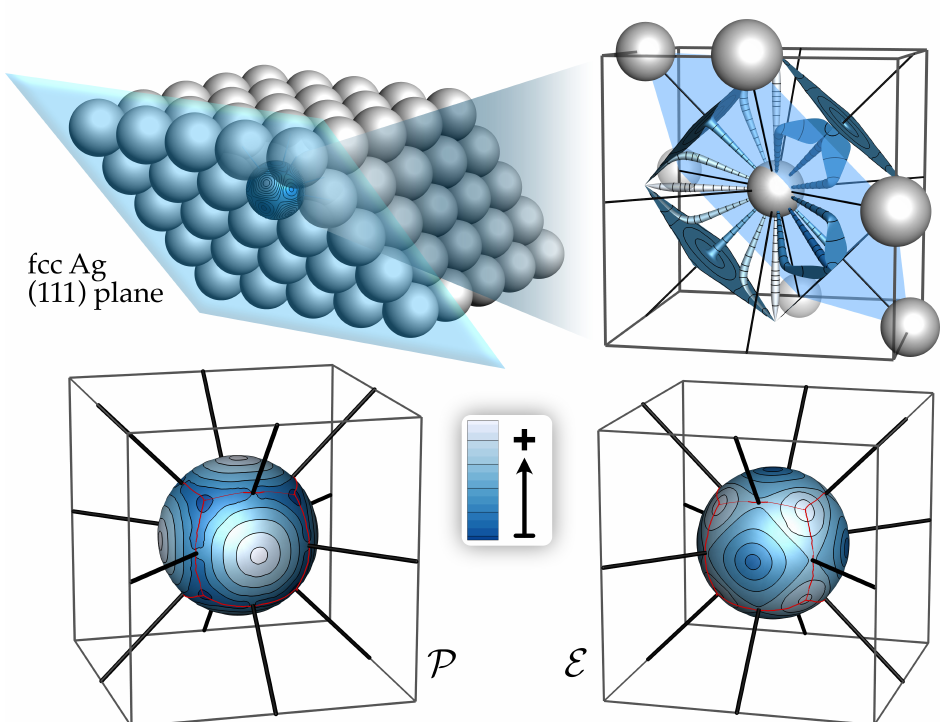
Figure 1. Top right, a sampling of differential gradient bundles tracing the shape of ρ in crystalline silver, lined with contours of ρ and colored according to the amount of ρ contained in each. Integrating the total energy and charge density in all such differential gradient bundles yields the 2D condensed total energy ( E ) and charge density ( P )